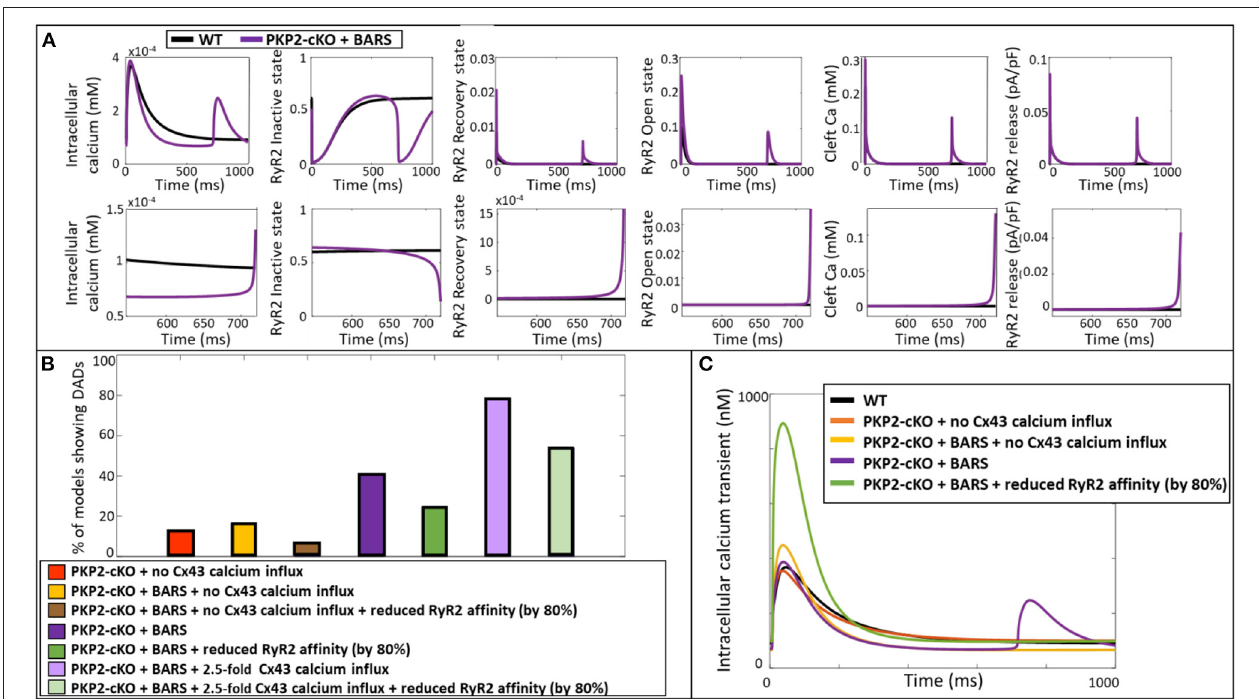
FIGURE 5 | (A) Representation of the intracellular calcium transient, RyR2 configuration (inactive, recovery and open state), cleft calcium levels and RyR2-mediated calcium release in the wildtype model (blue) and PKP2-cKO model with BARS (1.5-fold Cx43 hemichannel-mediated calcium influx incorporated) (purple). Bottom: Zoom-in on the zone of DAD occurrence. (B) Percentage of models showing DAD-like events when comparing PKP2-cKO model with no Cx43 hemichannel-mediated calcium influx with and without BARS, with or without reduced RyR2 affinity, PKP2-cKO model plus BARS (1.5-fold Cx43 hemichannel-mediated calcium influx incorporated), with or without reduced RyR2 affinity, as well as the PKP2-cKO model plus BARS and 2.5-fold Cx43 hemichannel-mediated calcium influx, with or without reduced RyR2 affinity. (C) Representative calcium transient traces of the different models. Please note the disappearance of DADs when reducing the RyR2 calcium affinity in the PKP2-cKO model in presence BARS (1.5-fold Cx43 hemichannel-mediated calcium influx still